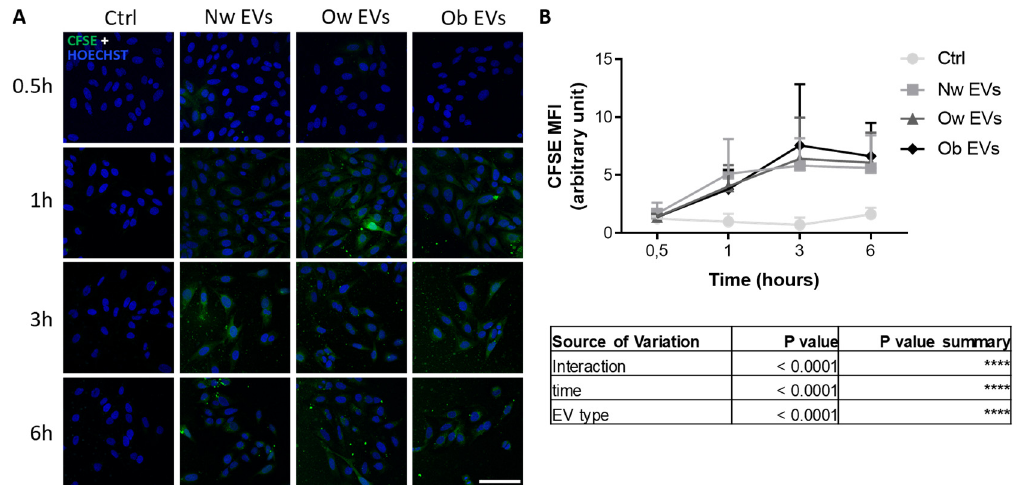
Figure 4. ( A ) Confocal microscopy analysis of mature osteoblasts treated for 0.5, 1, 3 and 6 h with CFSE + EVs from participants with normal weight (NW), overweight (Ow) and obesity. Pictures show the resultant recipient cells as proof of EV uptake. Nuclei were stained with Hoechst (blue). Scale bar: 100 µ m. ( B ) Mean fluorescence intensity (MFI) quantification of CFSE + osteoblasts following the treatment with CFSE + EVs. The table below shows the results from ANOVA 2-way